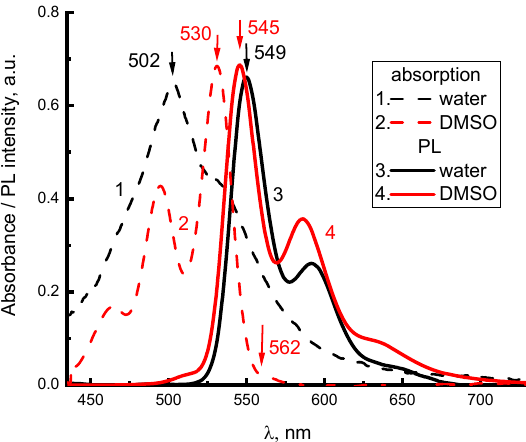
Figure 2. Spectra of absorption (1,2) and steady-state PL (3,4) of molecular solutions of 2416SL in DMSO (2,4) and water (1,3) at the concentration of 5 · 10 − 6 M, λ e = 385 nm, T = 296 K. Table 1. Positions of electronic absorption band maxima for solutions of 2416SL.